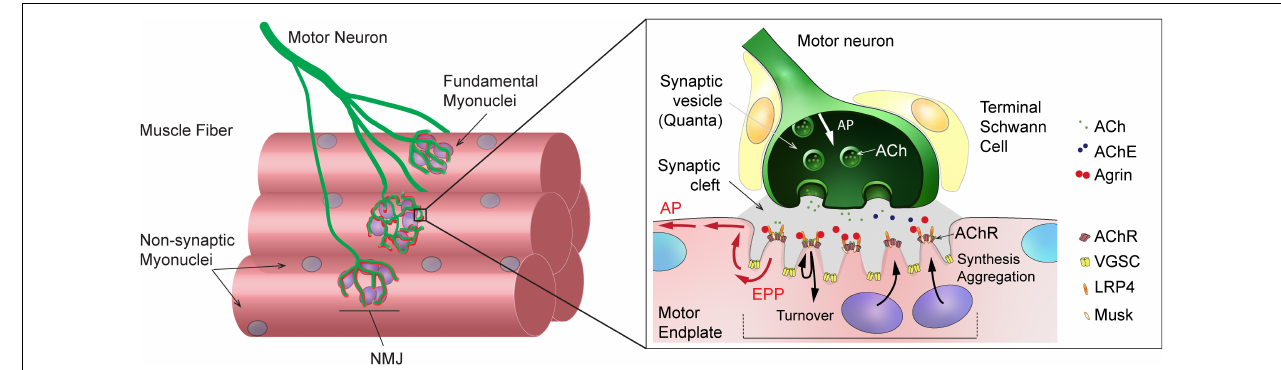
FIGURE 1 | General organization and function of mammalian neuromuscular junction (NMJ). Left: Scheme showing a motor axon, which branches and forms NMJs to innervate skeletal muscle fibers. Sub-synaptic (or fundamental) nuclei are seen underneath the NMJ. Right: Enlarged view of NMJ, showing capping Schwann cells in close contact with the muscle and axon, the junctional folds and the accumulation of synaptic proteins at the post-synaptic muscle membrane, and the liberation of synaptic vesicles at the pre-synaptic membrane upon action potential arrival. ACh, acetylcholine; AChE, acetylcholinesterase; AChR, acetylcholine receptor; AP, action potential; EPP, endplate potential; LRP4, LDL Receptor Related Protein 4; VGSC, voltage-gated sodium channel.